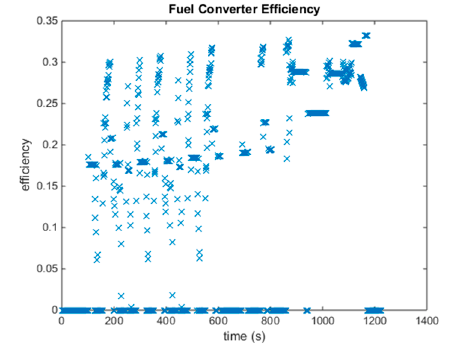
Figure 15. Fuel converter efficiency.